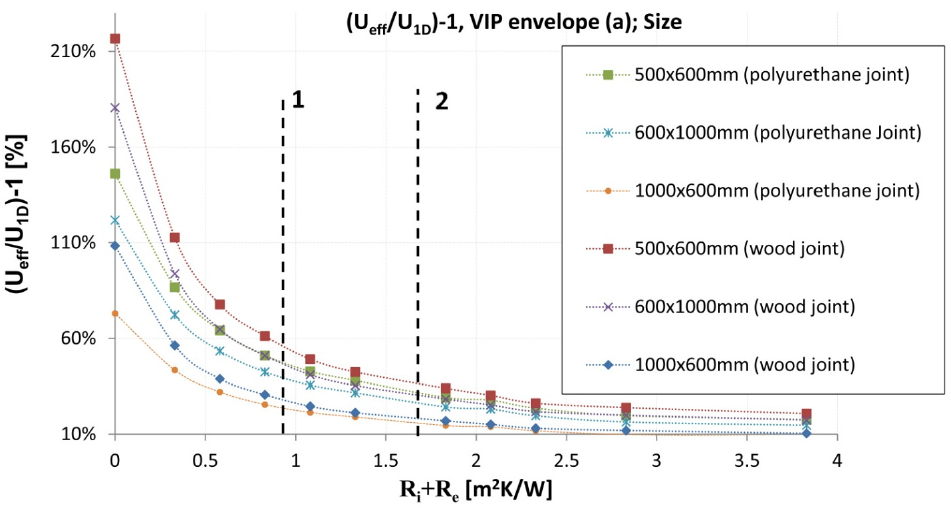
Figure 10. (U eff /U 1D )-1 values for VIP panel envelope (a) for three different sizes and